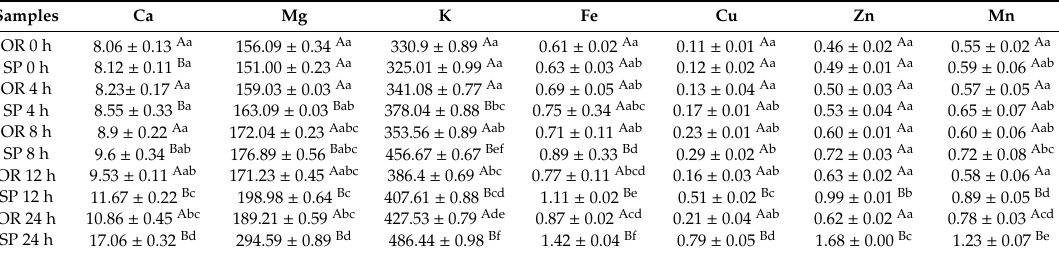
Table 4. Mineral content of OR and SP sourdoughs at di ff erent fermentation times. Samples Ca Mg K Fe Cu OR 0